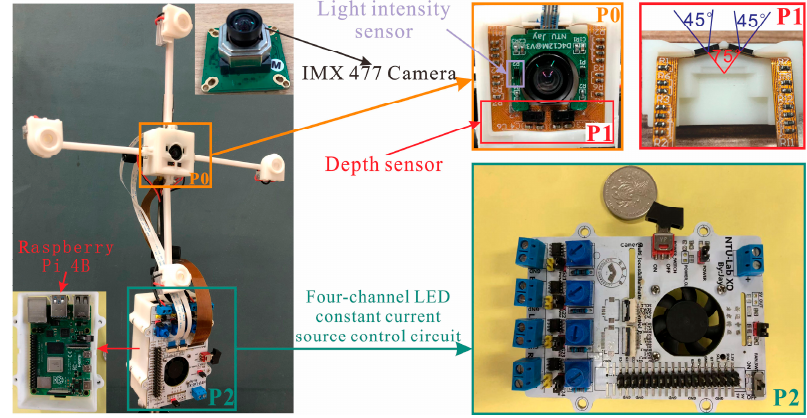
Figure 5. Composition of the imaging device.